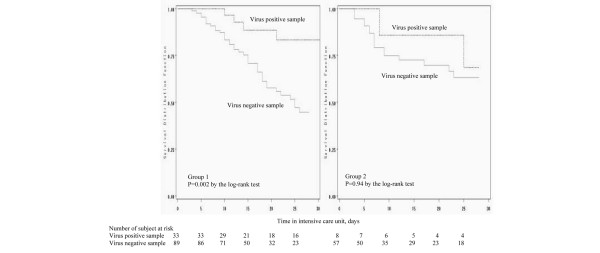
Survival according to viral screening and respiratory disorder at admission. Survival according to the result of viral screening on intubation in patients with (group 1) and without (group 2) respiratory disorder at admission.